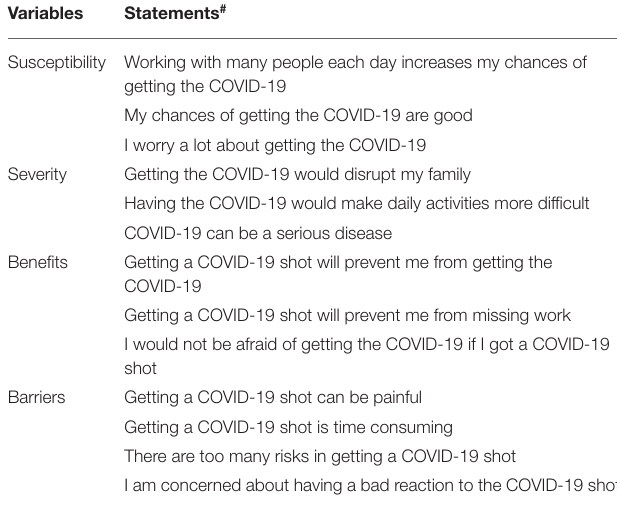
TABLE 1 | Health belief model